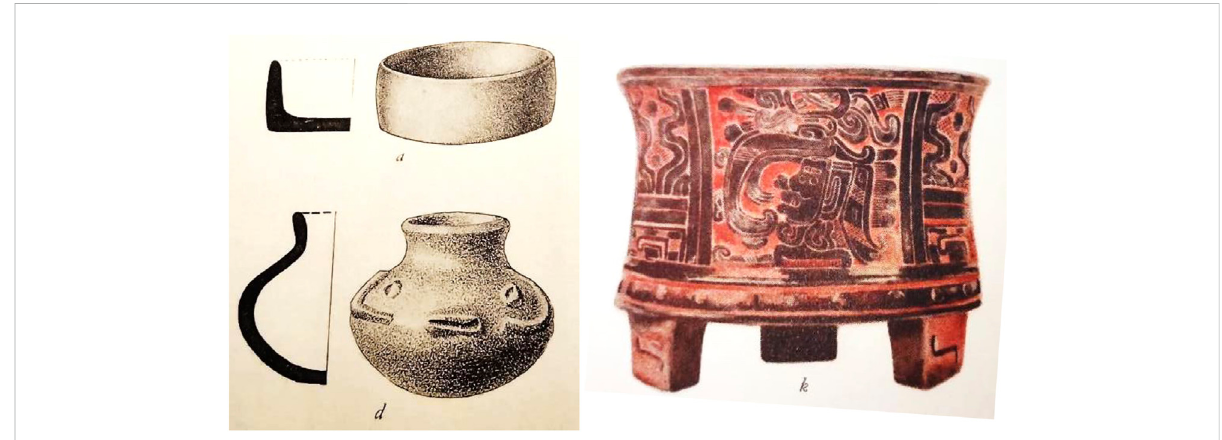
FIGURE 6 Early Classic mercury artefacts from the Maya site of Kaminaljuyu, southern Guatemala from Kidder et al. (1946). Two examples of small Maya paint pots found to have contained cinnabar (left), and a cinnabar-painted vessel (right). Elemental mercury was also reported at Kaminaljuyu (Table 2), but there is no imagery of this available. Credit: Carnegie Institution for Science: imagery reproduced with